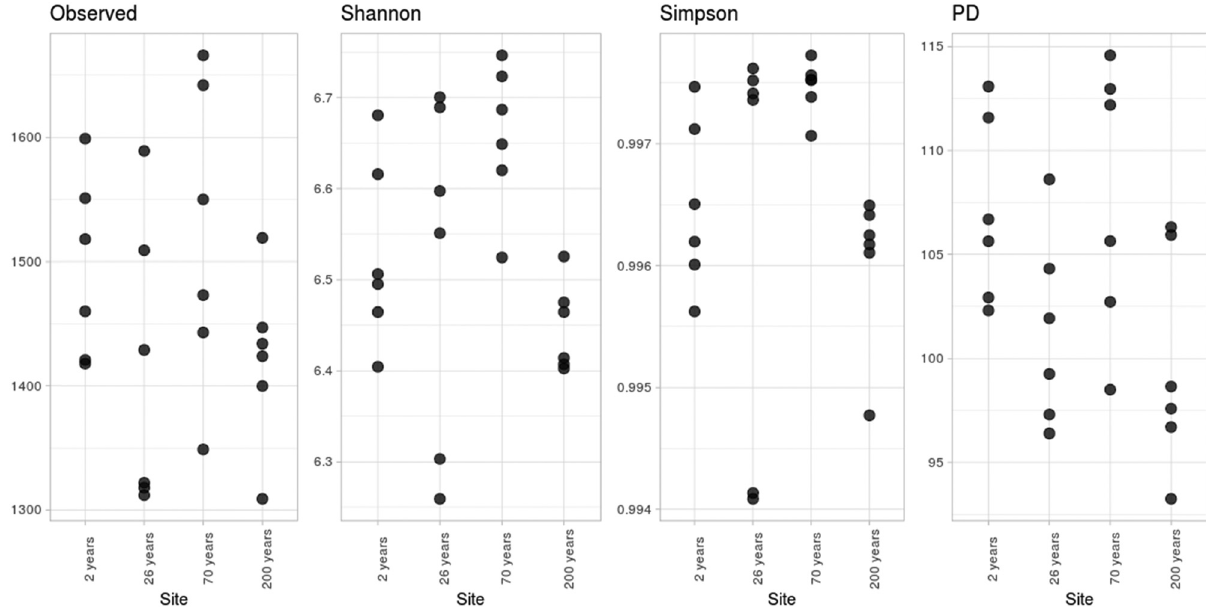
Figure 4: Alpha - diversity metrics.